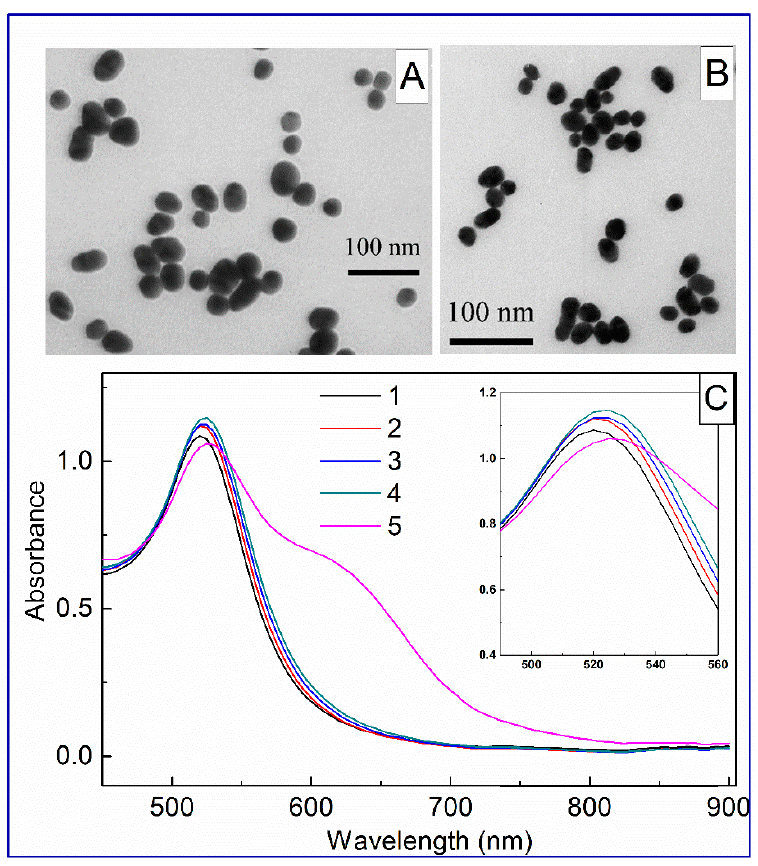
Figure 2. TEM image of bare AuNPs ( A ) and MBA-modified AuNP ( B ). ( C ) Absorbance spectra of bare AuNP (1) and Au MBA at 1 µM (2), 3 µM (3), 5 µM (4), and 10 µM (5) concentrations. The inset bare AuNP (1) and Au MBA at 1 µ M (2), 3 µ M (3), 5 µ M (4), and 10 µ M (5) concentrations. The inset shows an enlarged portion of spectra. shows an enlarged portion of